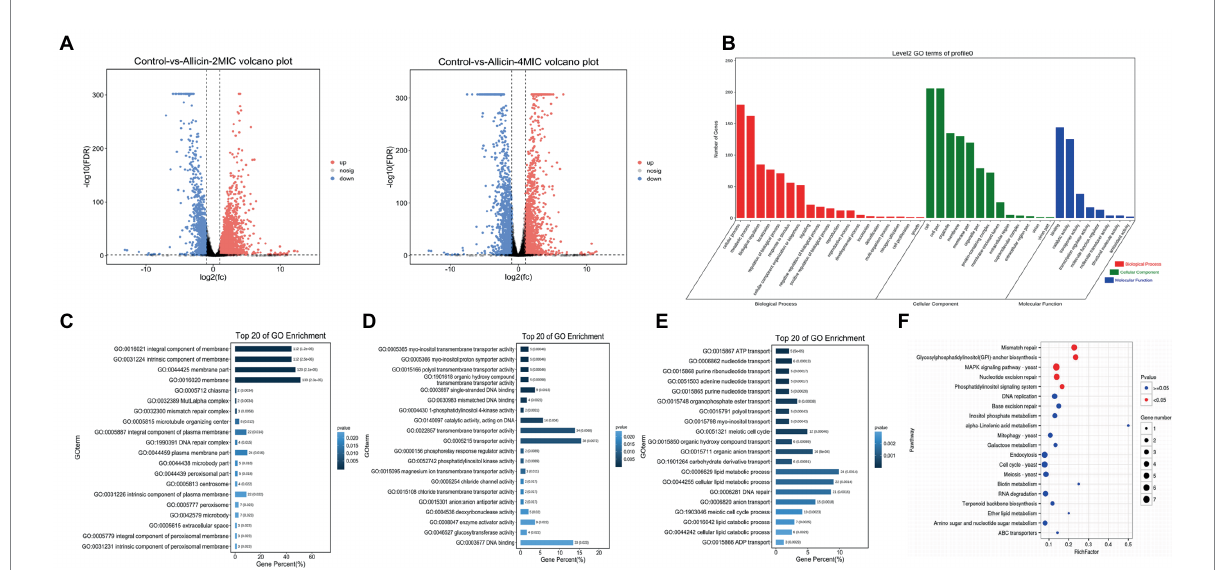
FIGURE 4 (A) Volcano plots of the genes that shows significantly differential expression after the 2 MIC and 4 MIC of alliin treatments compared with the normal group. The closer the genes are to the two ends, the greater the degree of difference. (B) GO map of putative target genes. The three colors describe the molecular function, cellular component and biological process of the genes. (C,D,E) GO enrichment bar graph. The first 20 GO terms with the smallest p value were used to draw the graph, the ordinate is the GO term, and the abscissa is the percentage of the number of GO terms for all differential genes. A darker color indicates a smaller p value, and the value on the column is the number of GO terms and p value. From left to right are the enrichment of cell components (C) , molecular functions (D) and biological processes (E) . (F) KO enrichment bubble graph. The first 20 pathways with the smallest p values were used to draw the map. The ordinate was the pathway, and the abscissa was the enrichment factor; that is, the differentially expressed genes in this pathway were divided by all the numbers. The size indicates the number, and a redder color indicates a smaller p